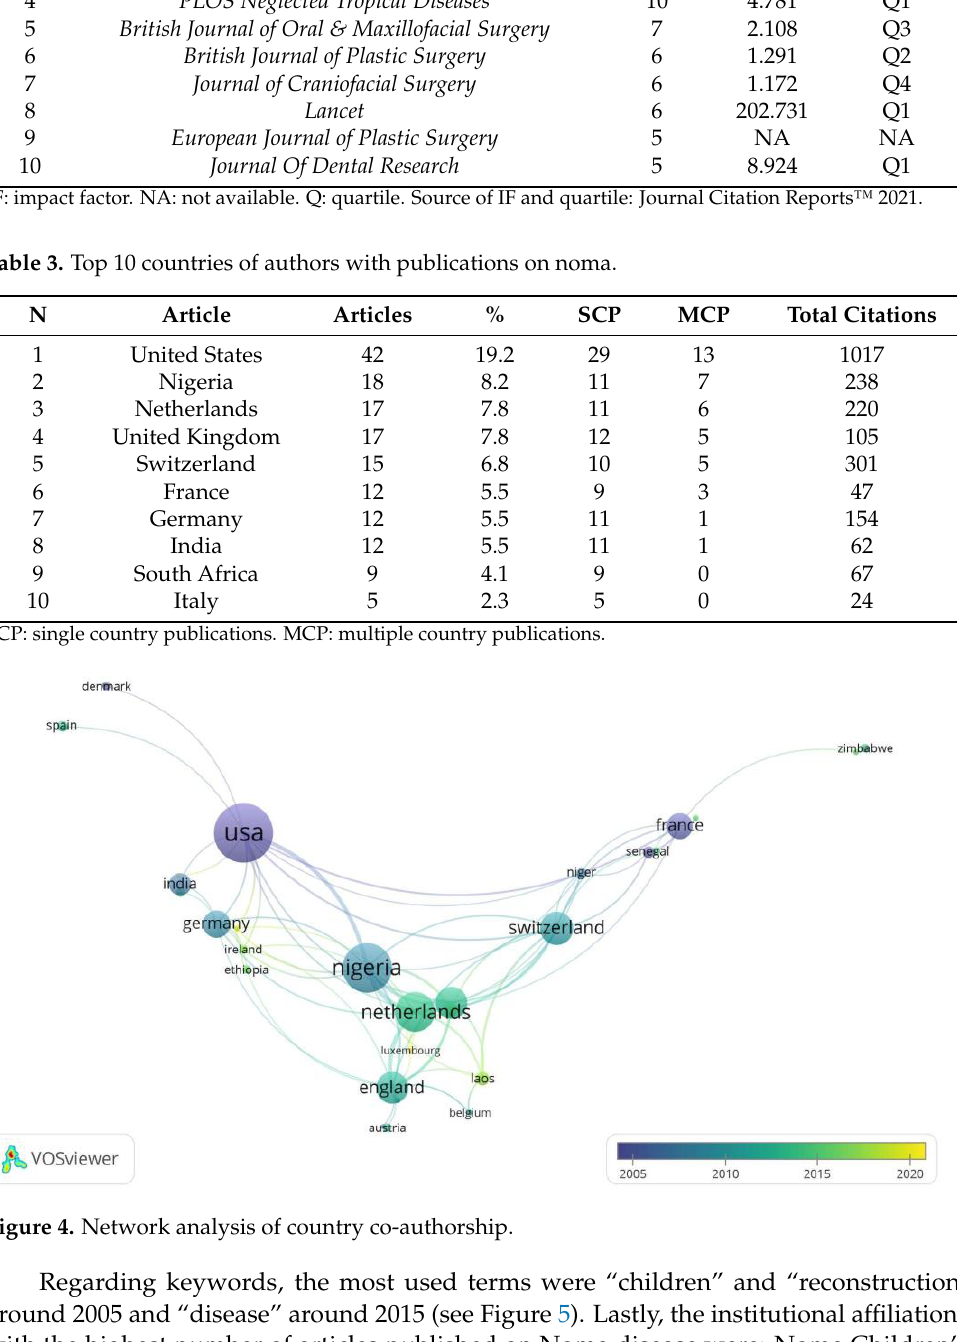
Figure 5. Network analysis of co-occurrence of terms.